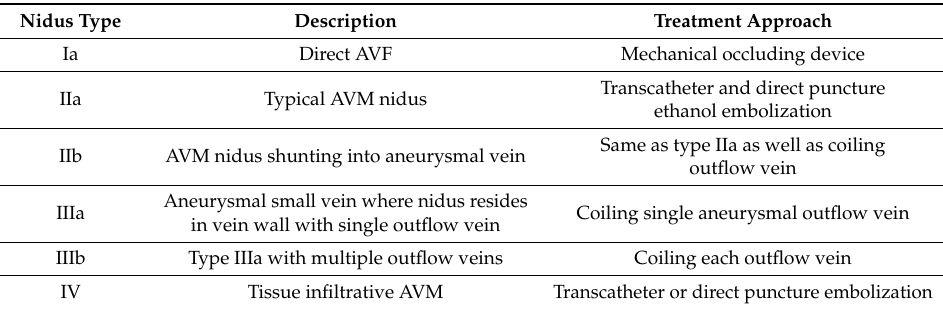
Table 2. Yakes AVM classification system